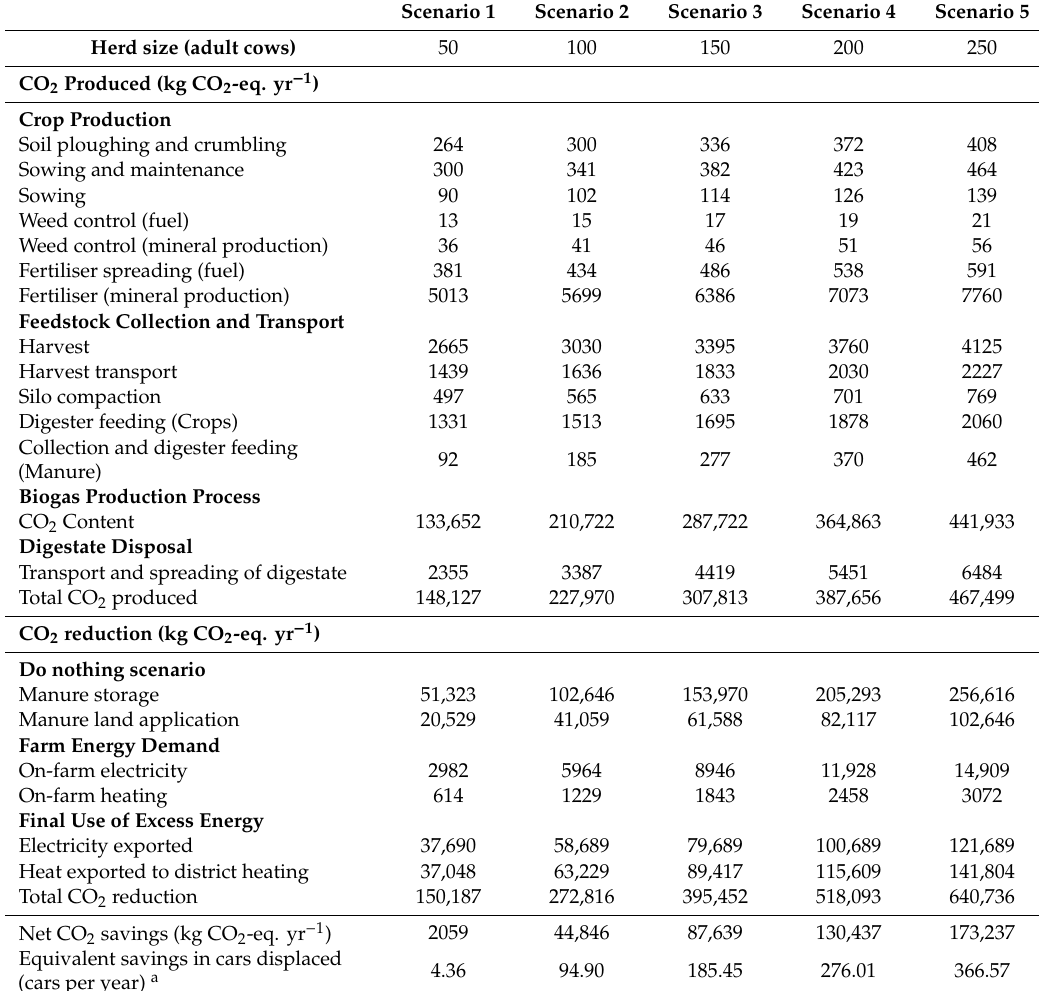
Table 6. Annual CO 2 balance for scenarios under